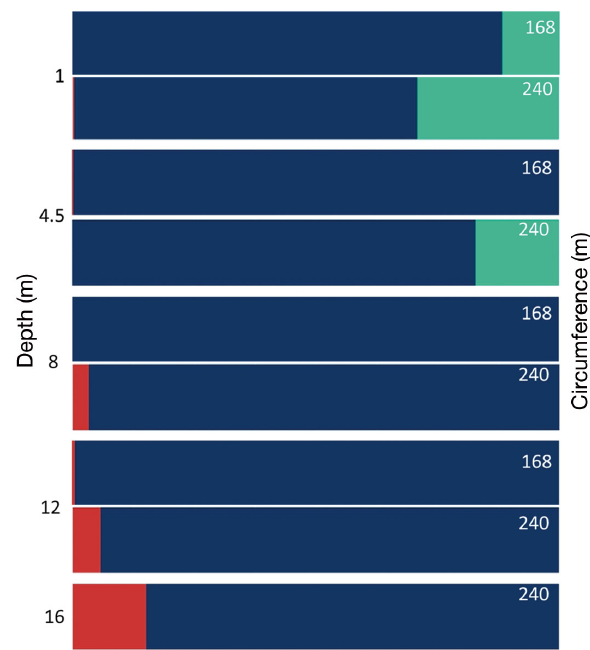
Fig. 5. Proportions of collected dissolved O 2 measurements which fall within identified production thresholds: below dissolved O 2 of maximum feed intake (red), within ideal conditions (blue) and super-oxygenated (green). The num- ber in the upper right corner denotes cage size (circum - ference in m), and numbers on the left side identify meas- urement depth